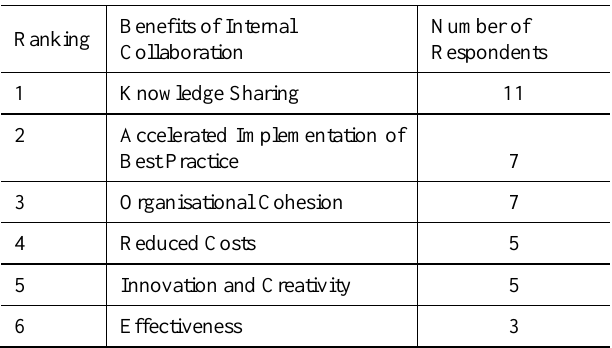
Table 1: Benefits of internal